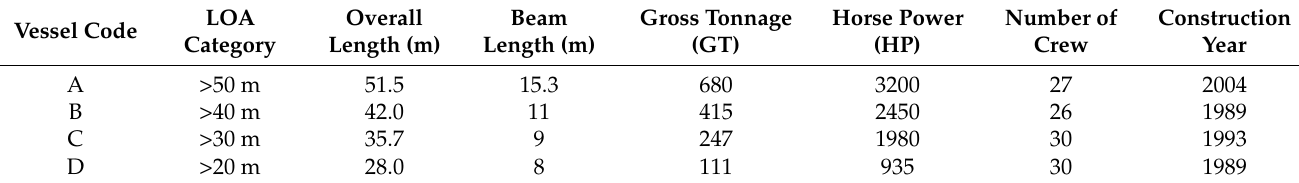
Table 2. Four categories of purse seine vessels and their